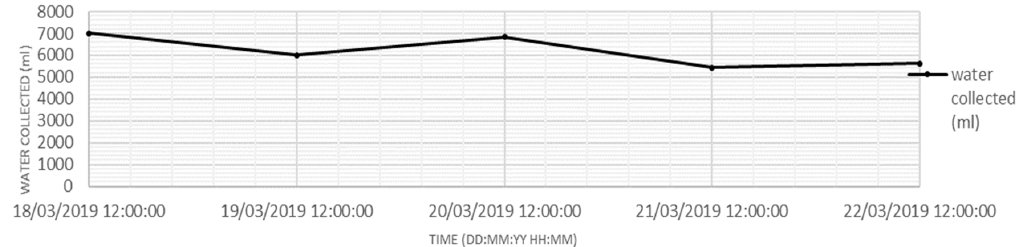
Figure 19. The amount of water from the dehumidification process in the third week.